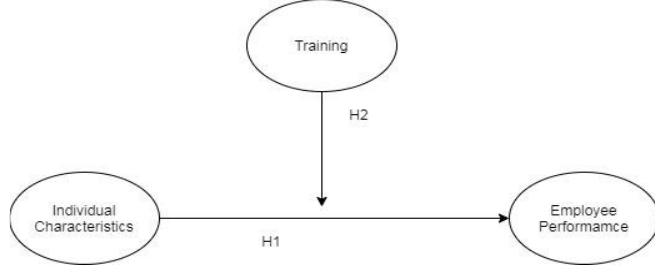
Figure 1: Reseach Framework and